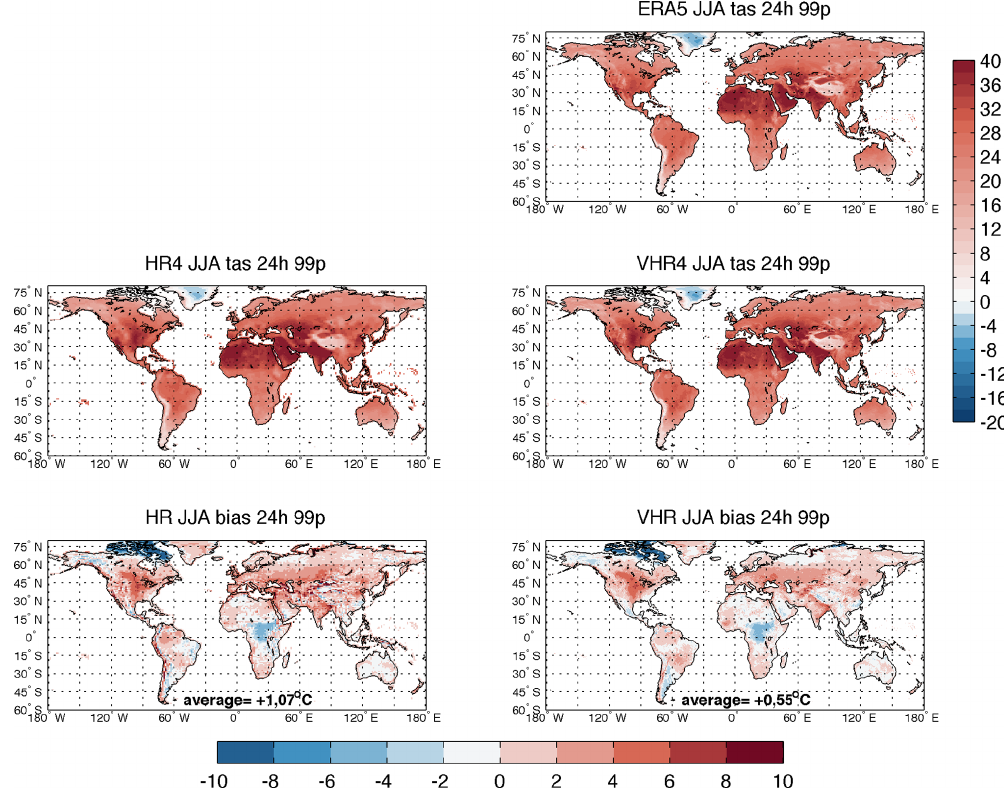
Figure 2. Summer (June, July, August, JJA) extreme temperature (99th percentile, 99p) computed at the daily frequency. Upper panel shows ERA5 results. Central panels show model results (HR on the left and VHR on the right) and lower panels show the relative model bias. Units are [ ◦ C]. Vertical color bar refers to the three upper panels, while the horizontal color bar refers to the two bottom panels.